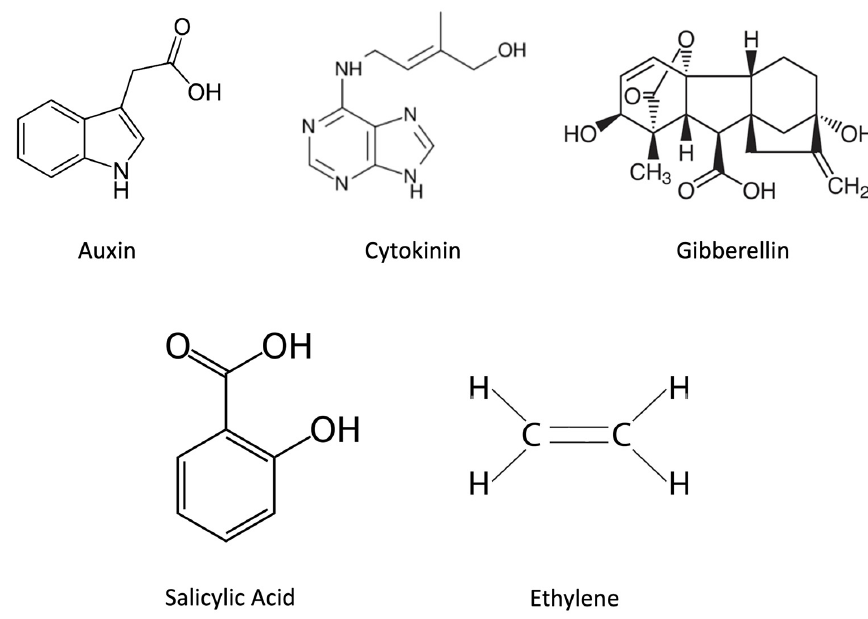
Figure 1. Chemical structures of PGPB ‐ synthesized